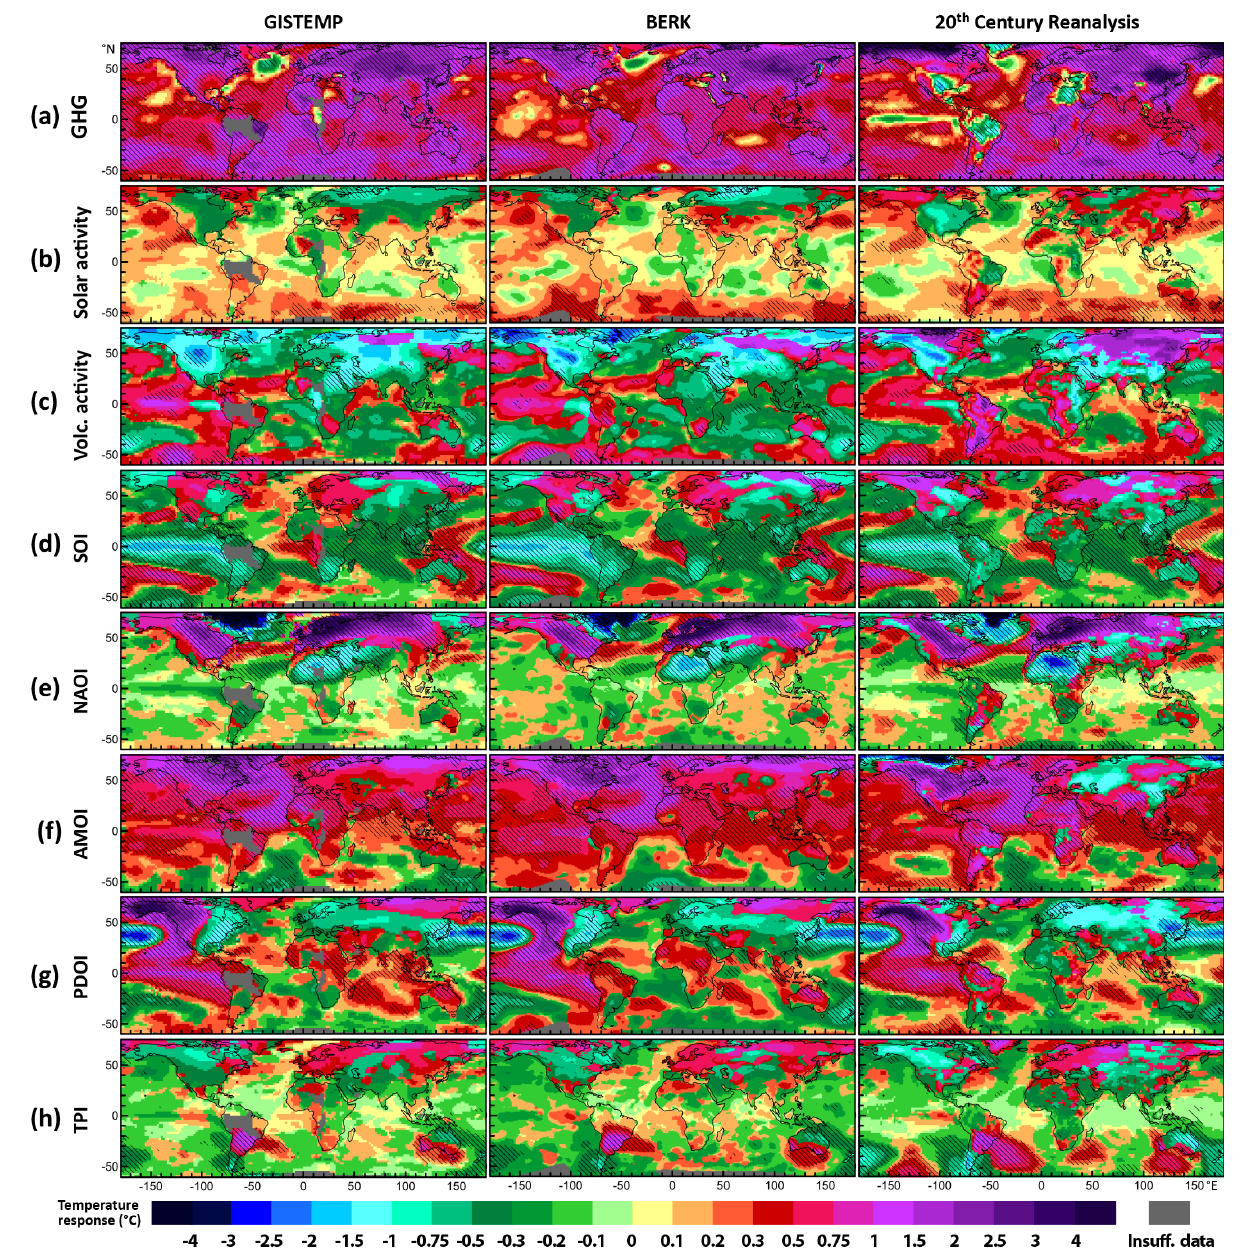
Figure 7. Geographic distribution of the strongest temperature response ( ◦ C) to individual explanatory variables within the ± 24 month range of the temporal offset of the predictor. Areas with the response statistically significant at the 99% level are highlighted by